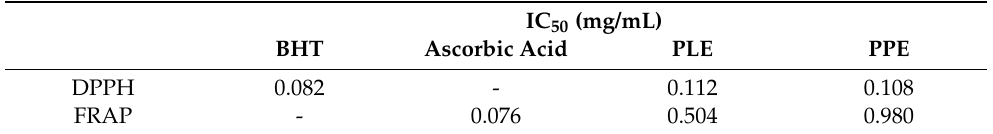
Figure 3. Ferric reducing antioxidant power (FRAP) assay of PPE and PLE. Results were expressed as mean radical scavenging activity percentage (%) ± standard deviations ( n = 3). Ascorbic acid was used as the reference standard.